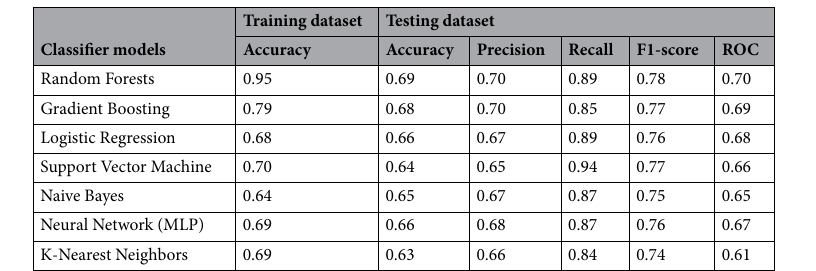
Figure 5. Exploratory data analysis of the dataset. ( a ) The plot was created using lumbar and femoral BMD change after treatment, which consisted of n = 13,562 treatment profiles. The color intensity of hexagon bins represent the density of treatment profiles. ( b ) The boxplot, with outliers removed, of anti-osteoporosis drug prescription and treatment response pattern of normal-BMD, osteopenia, and osteoporosis groups were shown.